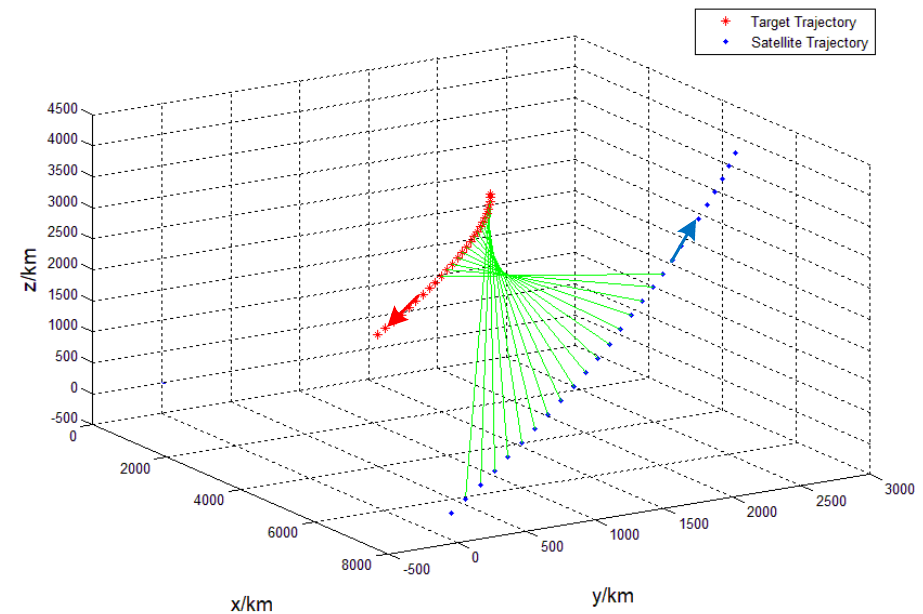
Figure 12. Trajectory of satellite and target with access link.